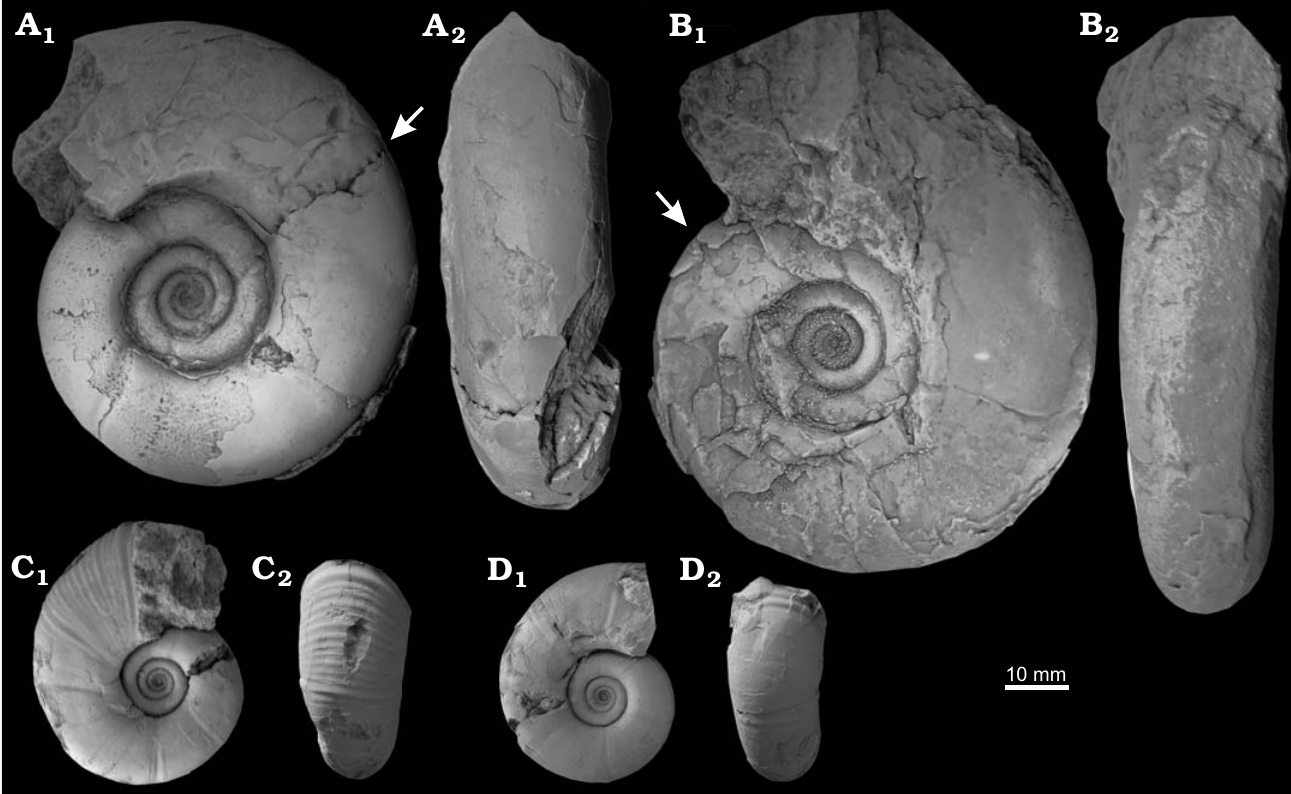
Fig. 5. The gaudryceratid ammonoid Anagaudryceras , early Campanian (Upper Cretaceous) of Antarctica, from Rabot Formation, Redonda Point locality (A, B) and from Santa Marta Formation, Brandy Bay locality (C, D). A , B . Anagaudryceras cf. A. politissimum (Kossmat, 1895). A . CADIC PI 455. B . CADIC PI 454. C , D . Ana gaudry ceras sp. juvenile 1. C . CADIC PI 533. D . CADIC PI 534. In lateral (A 1 –D 1 ) and ventral (A 2 –D 2 ) views. Arrows mark the beginning of the body